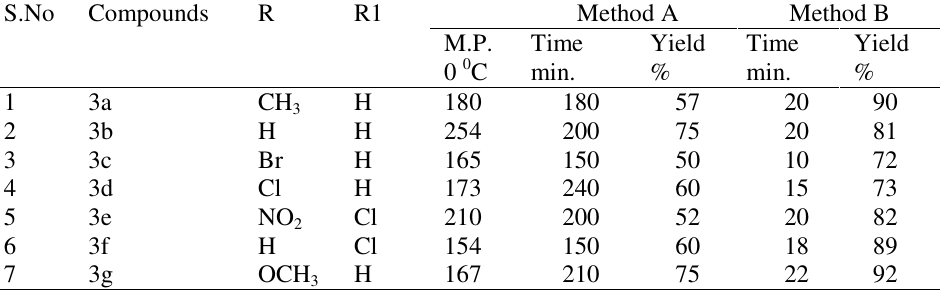
Table 1. Comparison of conventional versus microwave-assisted synthesis of 2,4- disubstituted oxazoles ( 3a-g